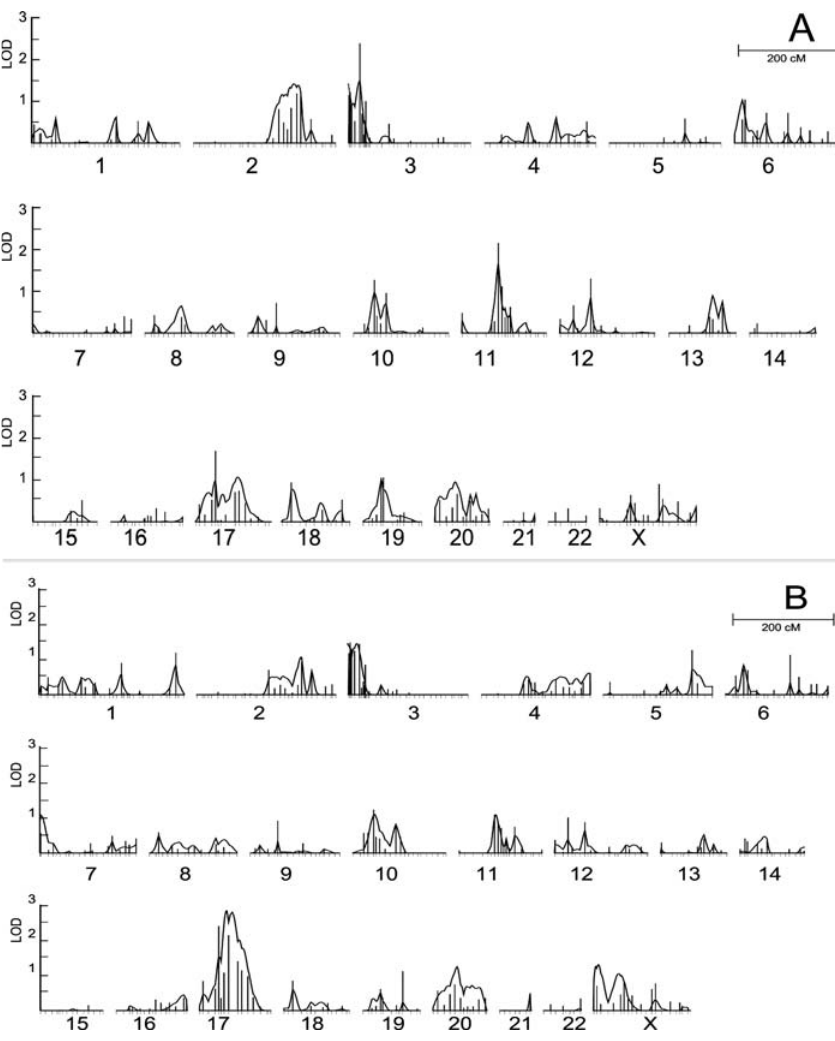
Figure 1. A Genome-Wide Scan of CAD and MI A genome-wide scan of CAD—broad CAD phenotype, 1,464 ASPs (A), and MI—narrow phenotype, 739 ASPs (B). Genetic location (abscissa) is scaled in KosambicM.LOD(ordinate)denotesthemaximumLODscorestatistic.ThesolidlineshowsmultipointLODscalculatedatregularintervals;theverticalbars showsingle-pointLODs(i.e.calculatedateachmicrosatellitemarker).Thelocationofeachmicrosatellitemarkerisshownbyanexternaltickontheabscissa. DOI: